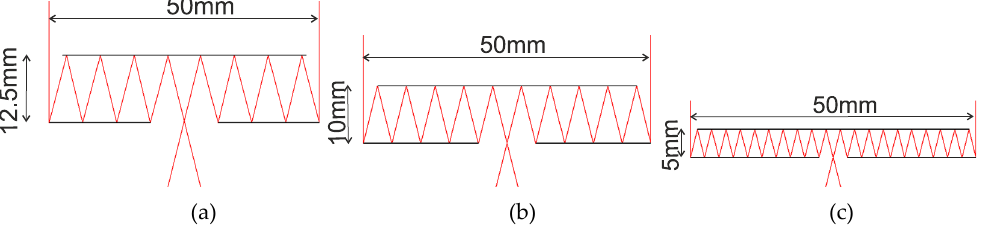
Figure 4. Ray tracing when focusing on the surface of the first mirror in an optical imaging system with an annular aperture D = 50 mm, f = 100 mm. ( а ) s = 12.5 mm and d = 12.5 mm, on-axis plane wave; ( b ) s = 10 mm and d = 10 mm, on-axis plane wave; and ( c ) s = 5 mm and d = 5 mm, on-axis plane wave.